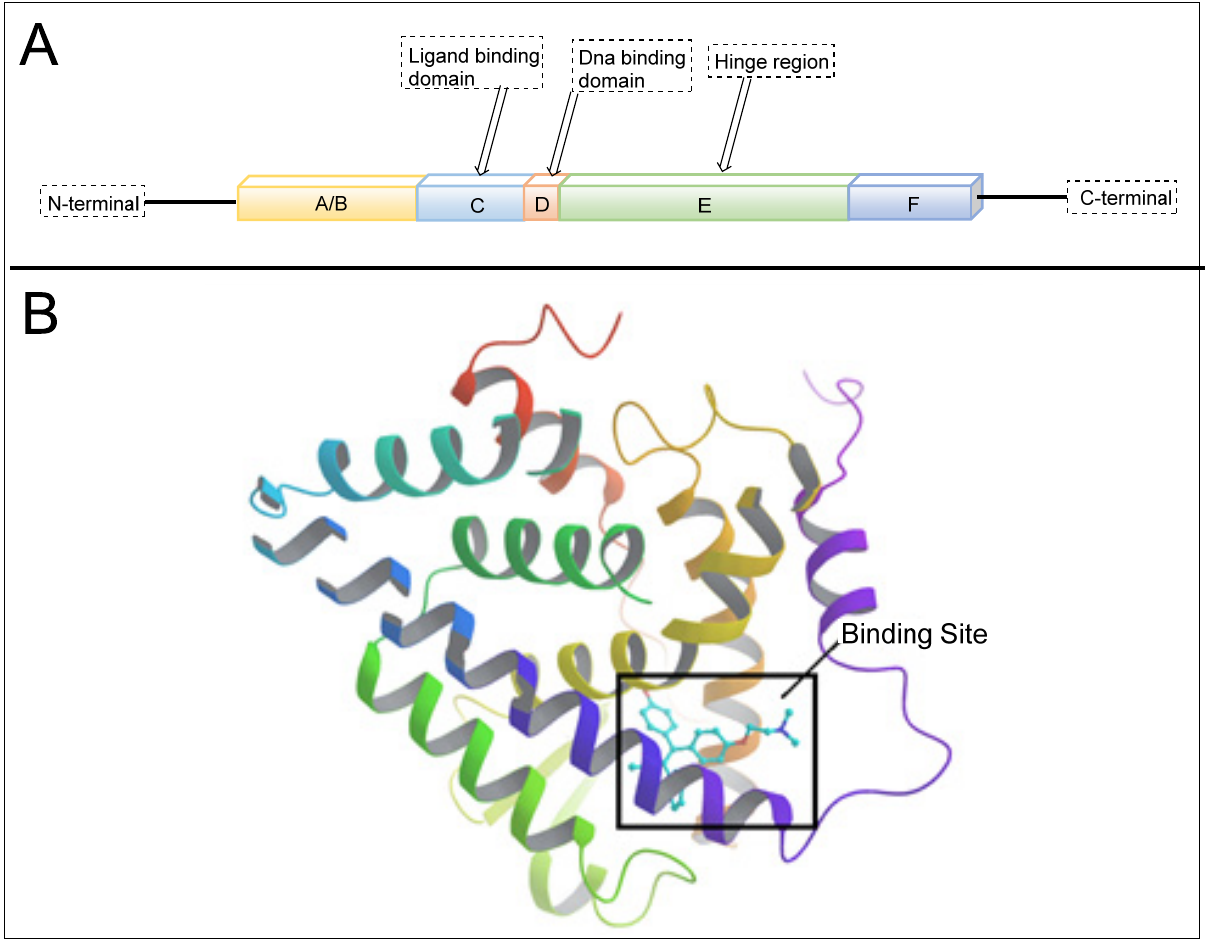
Figure 1. ( A ) Structure of estrogen receptor. ( B ) The binding site of ER- α .